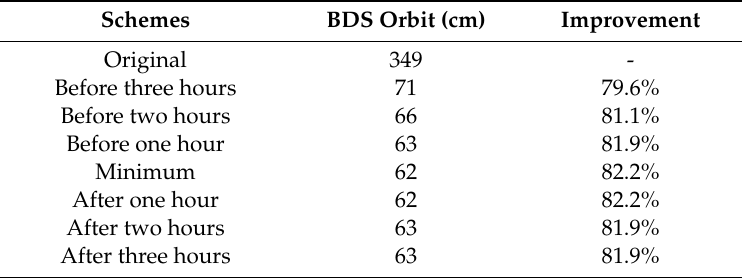
Table 8. Accuracy of the BDS’ predicted orbit and